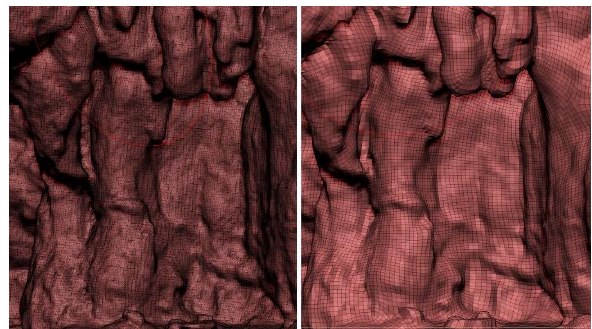
Figure 9. Comparison between the mesh obtained from Scene and the one optimized with